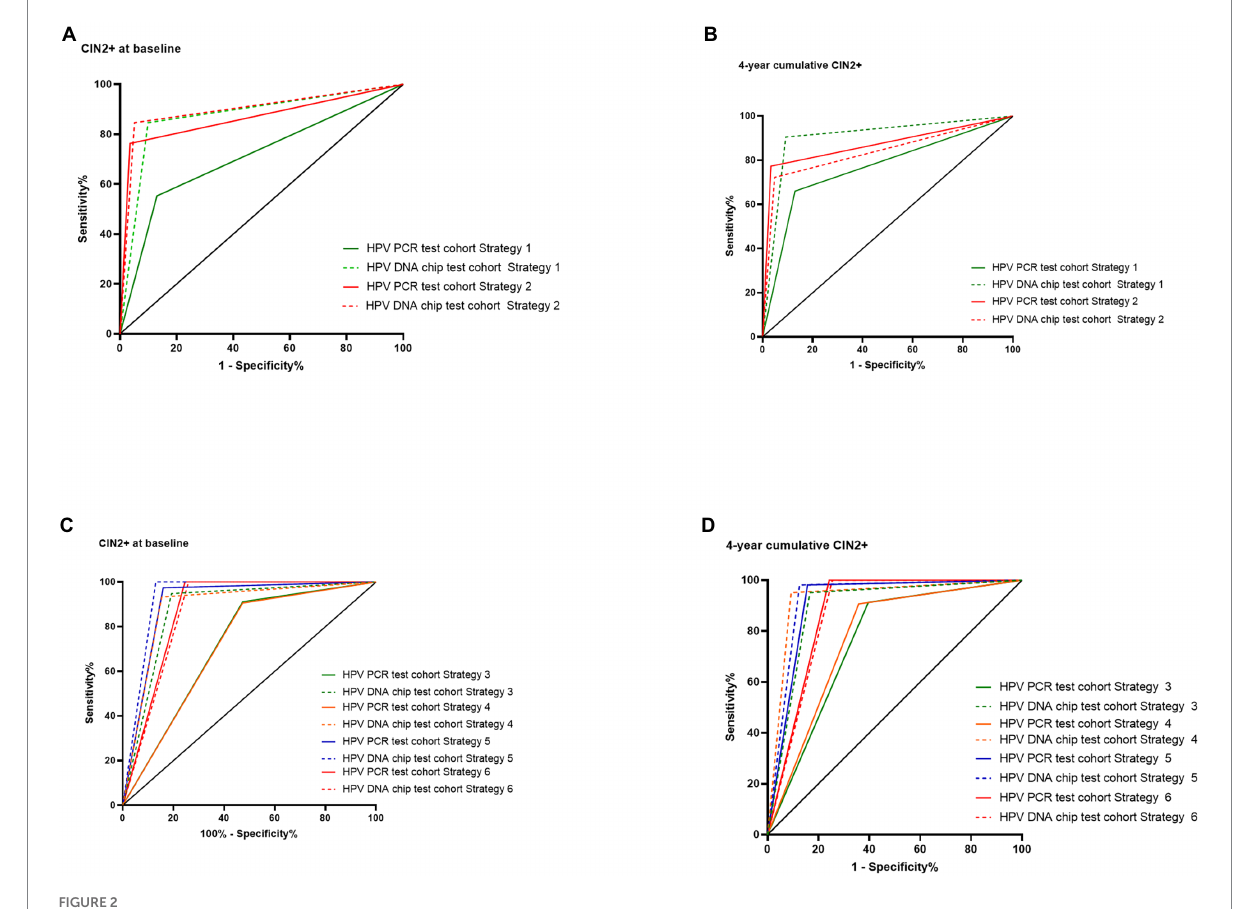
FIGURE 2 ROC curves of HPV DNA Chip and PCR testing techniques in different screening